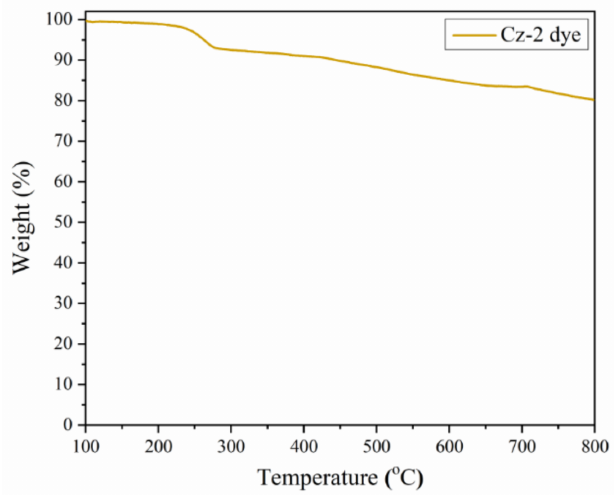
Figure 2. Thermogravimetric analysis (TGA) thermogram of the Cz-2